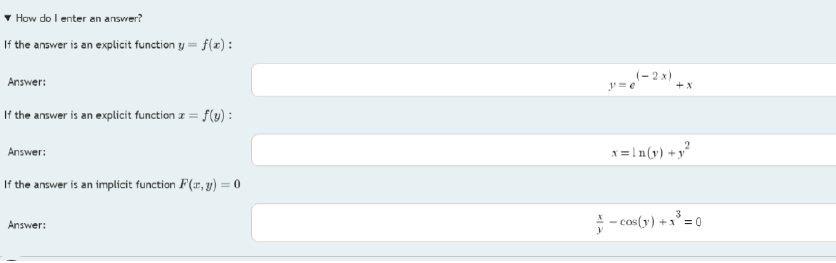
Fig. 5. An example of a problem for a